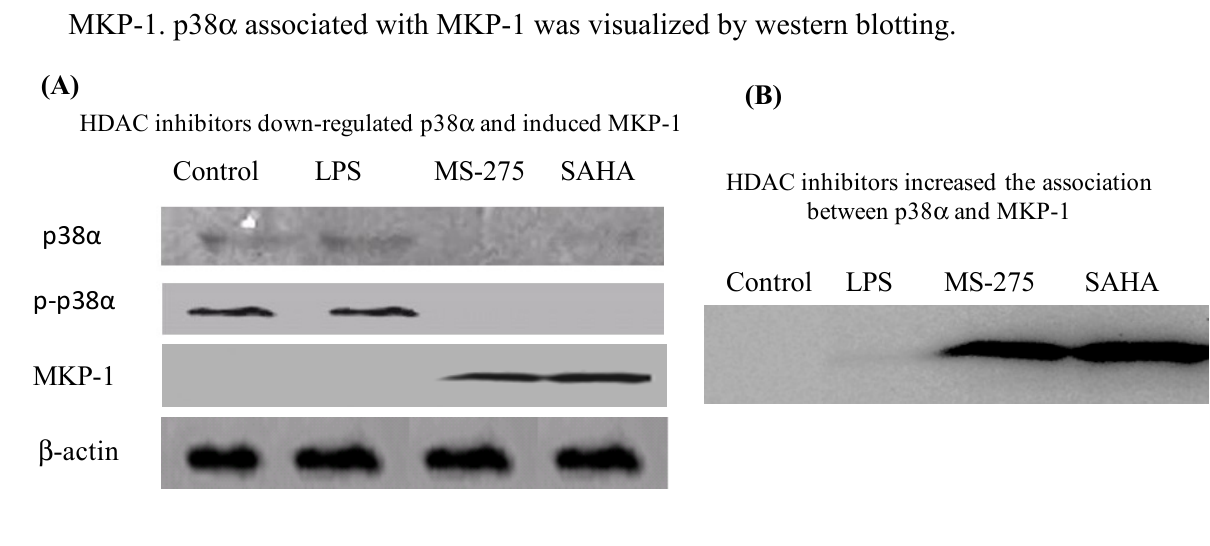
Figure 1. HDAC inhibitors suppressed p38 MAKP signal pathway. ( A ) MS-275 and SAHA down-regulated p38 α , phosphorylated-p38 α (p-p38 α ) and induced MKP-1. E11 cells were incubated with HDAC inhibitors (50 nM) for 1 h before they were stimulated by LPS. 24 h later, the profiles of p38 α , p-p38 α and MKP-1 were assessed by western blotting. Gel sections were obtained from different gels for each tested antibody, as indicated by the divided lines. ( B ) MS-275 and SAHA enhanced association between p38 and MKP-1. E11 cells were incubated with HDAC inhibitors (50 nM) for 1 h before they were stimulated by LPS. 24 h later, the nuclear extract was immunoprecipitated with antibody specific to MKP-1. p38 α associated with MKP-1 was visualized by western